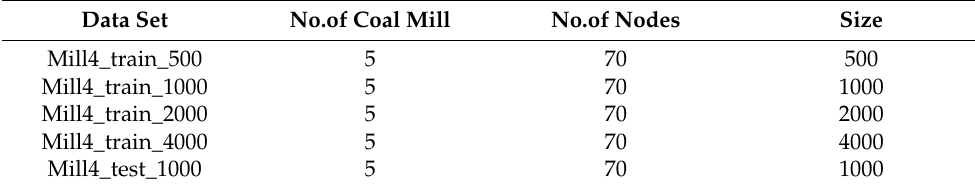
Table 5. General information of coal mill process abnormity diagnosis data sets. Data Set Data